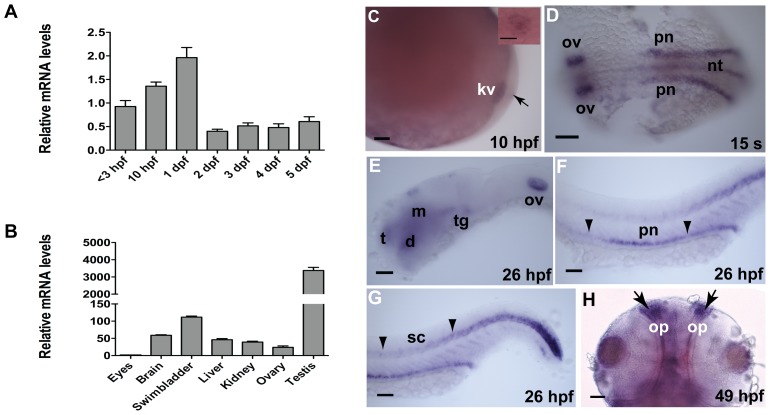
Expression of dyx1c1 mRNA during embryonic development and in adult tissues.qPCR analysis of the transcript levels of dyx1c1 during embryonic development (A) and in adult tissues (B). Whole-mount in situ hybridization showed that dyx1c1 is expressed in KV at 10 hpf (C). Inset in C is a close-up view of KV. At 15-somites, dyx1c1 was expressed specifically in the otic vesicle, pronephros and neural tube (D). At 26 hpf dyx1c1 was detected in the brain and is still maintained in otic vesicle, pronephros and spinal canal (E–G). Later at 49 hpf, dyx1c1 was visible in the olfactory placode (H). Panels E–G show lateral views of embryos. Panels D and H show dorsal and ventral views of embryos, respectively. Scale bars indicate 100 µm. Abbreviations: KV, Kupffer’s vesicle: nt, neural tube: pn, pronephros: t, telencephalon: d, diencephalon: m, midbrain: tg, tegmentum: ov, otic vesicle: sc, spinal canal: op, olfactory placode.